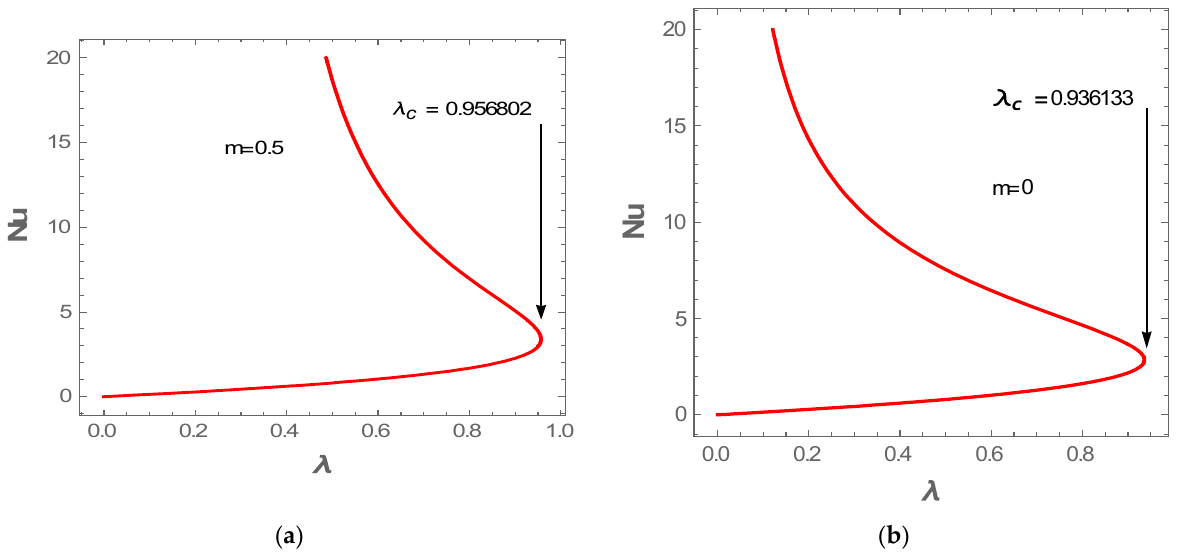
Figure 14. ( a )-Bifurcation for bimolecular reaction. ( b )-Bifurcation for Arrhenius kinetics.